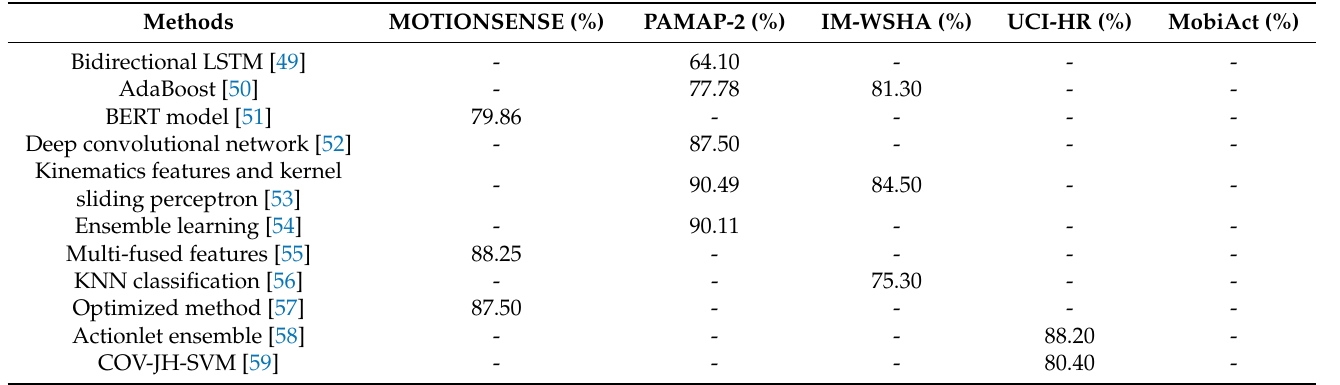
Table 8. Comparison of the recognition rate of the proposed HPAR model with other state-of-the-art methods from the IM-WSHA, PAMAP-2, UCI-HR, MobiAct, and MOTIONSENSE